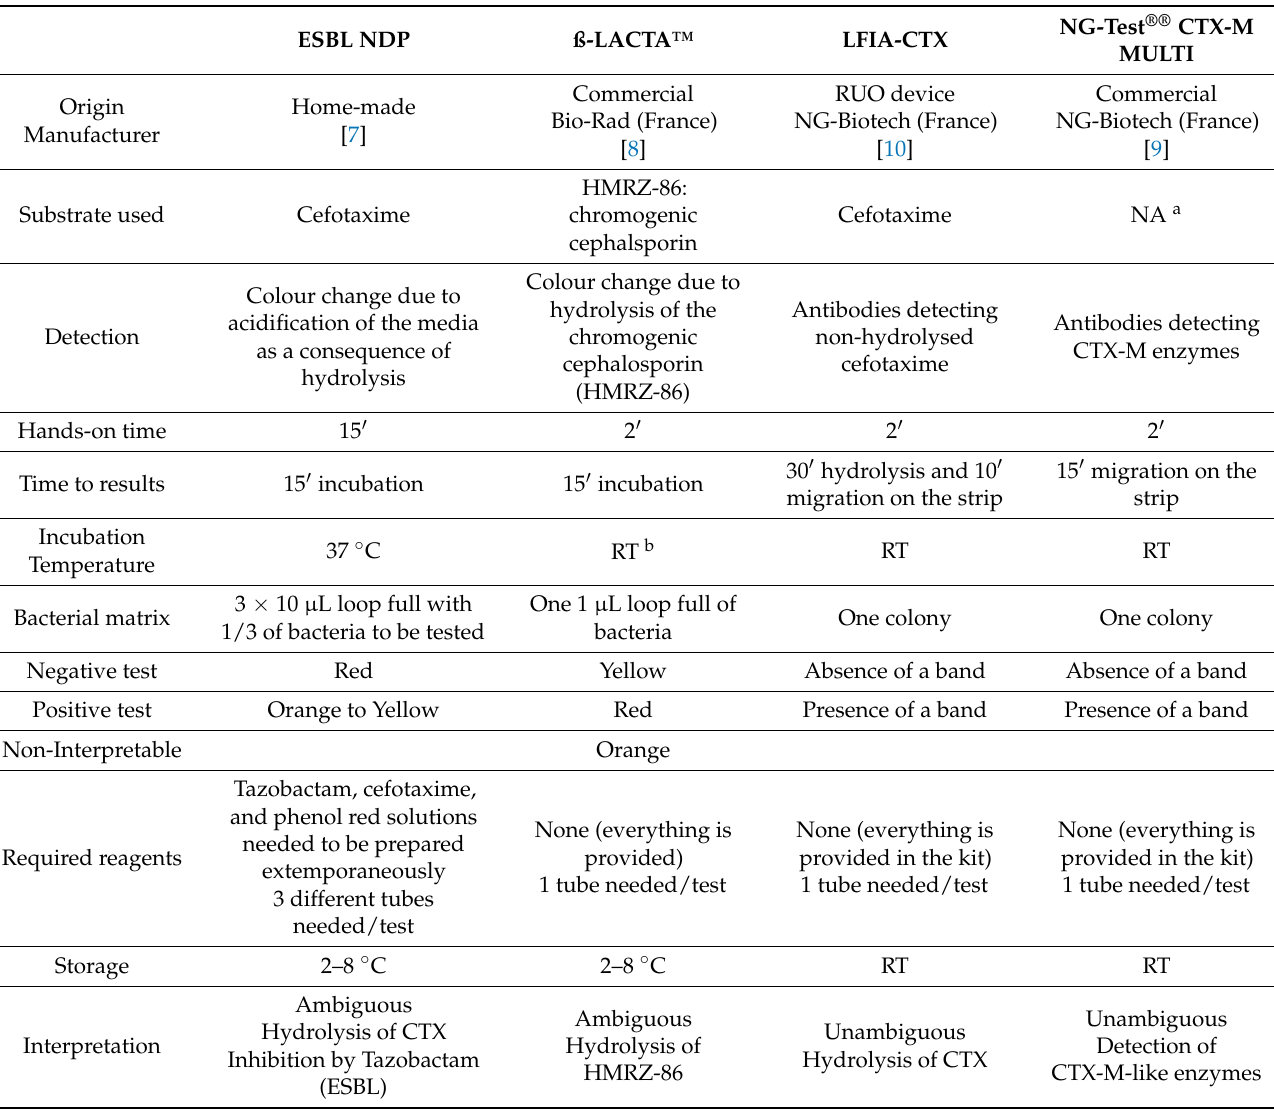
Table 1. Comparison of the three biochemical hydrolysis assays and the NG-Test CTX-M MULTI assay that detects all CTX-M-like